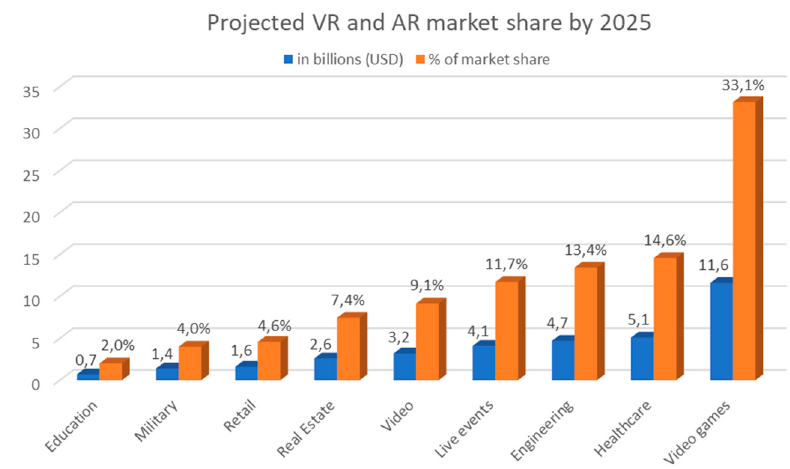
Figure 1. Projected global augmented reality (AR) and virtual reality (VR) market share, by use case in billions (USD) by 2025